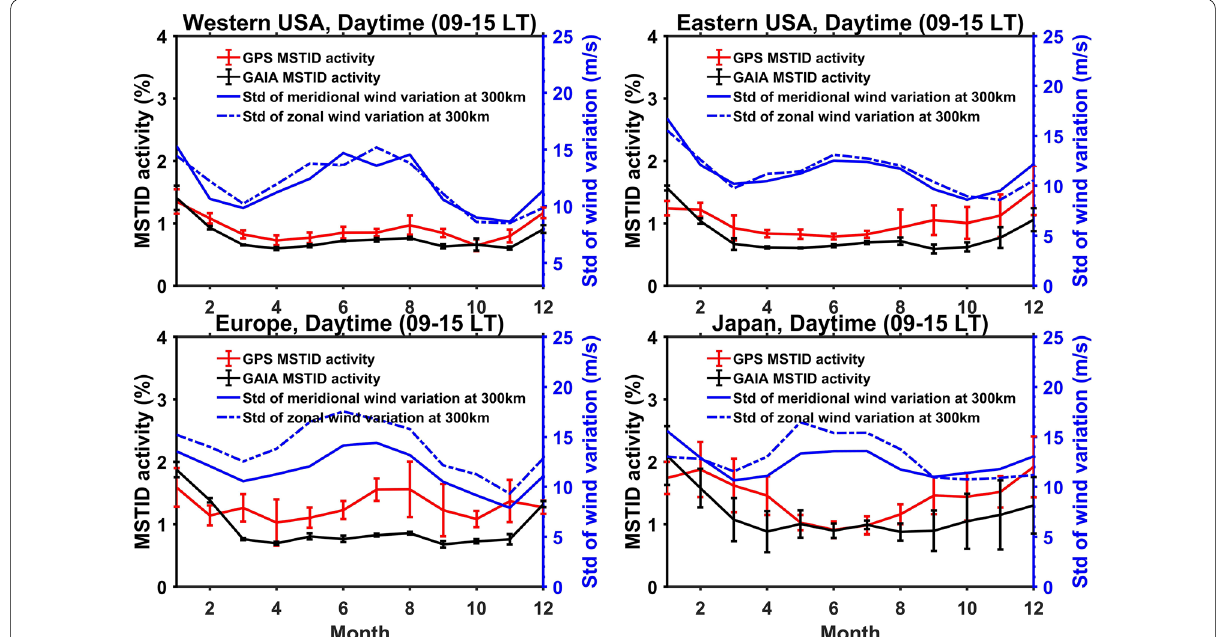
Fig. 3 Seasonal variation of daytime (09:00–15:00 local time averaged) MSTID activity in GPS observation (red), and GAIA simulation (black) at (left top) Western USA, (right top) Eastern USA, (left bottom) Europe and (right bottom) Japan in the northern hemisphere. Error bar indicates the standard deviation of MSTID activity. Standard deviation of zonal and meridional wind variation at an altitude of 300 km, simulated by GAIA is shown by the blue